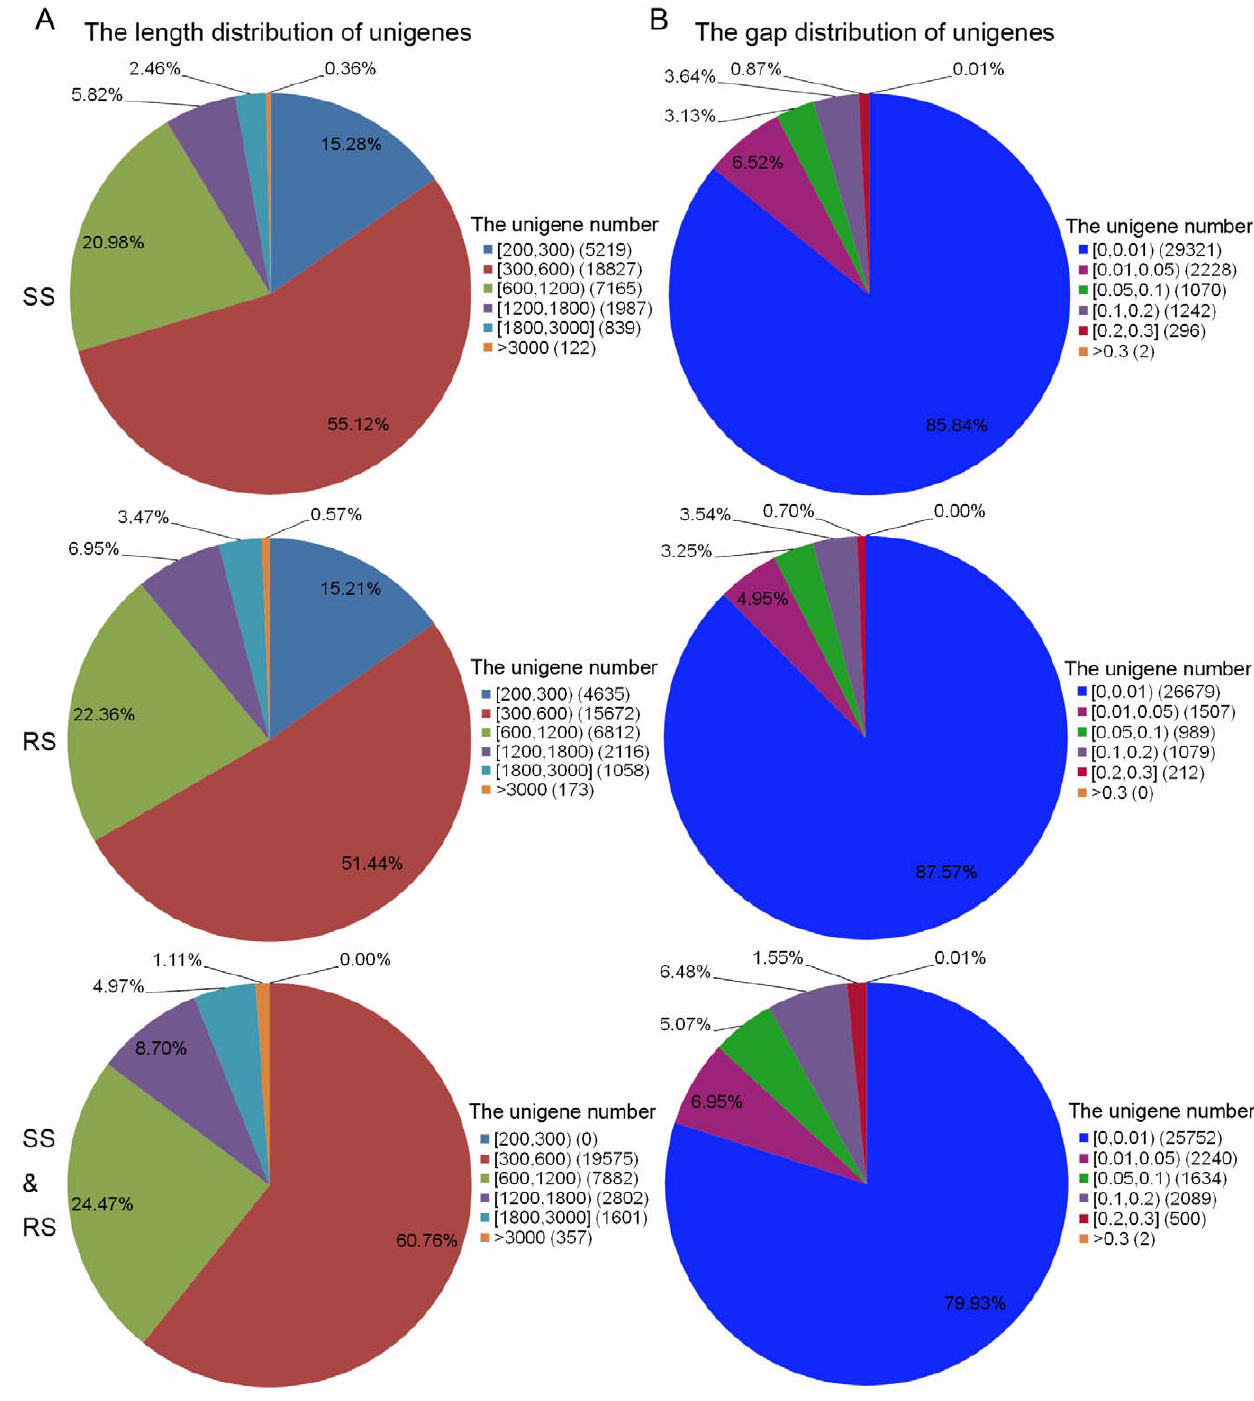
Figure 1. The length and gap distribution of unigenes after denovo assembly using the reads from SS, RS and SS&RS samples. A: Length distribution of unigenes. Numbers in square brackets (e.g., [200,300) and [1800,3000]) indicate the range of unigene length, while ‘ . 3000’ indicates unigenes longer than 3,000 bp. Numbers in parentheses (e.g., (5219) and (18827)) indicate the total number of unigenes falling in this length range. B: Gap distribution of unigenes. Values in squarebrackets indicate the ratio of the N number and allnucleotide base pair number for one unigene. Numbers in parentheses (e.g., (29321) and (2228)) indicate the number of unigenes that lie in the gap ratio (e.g., [0, 0.01) and [0.01, 0.05)).